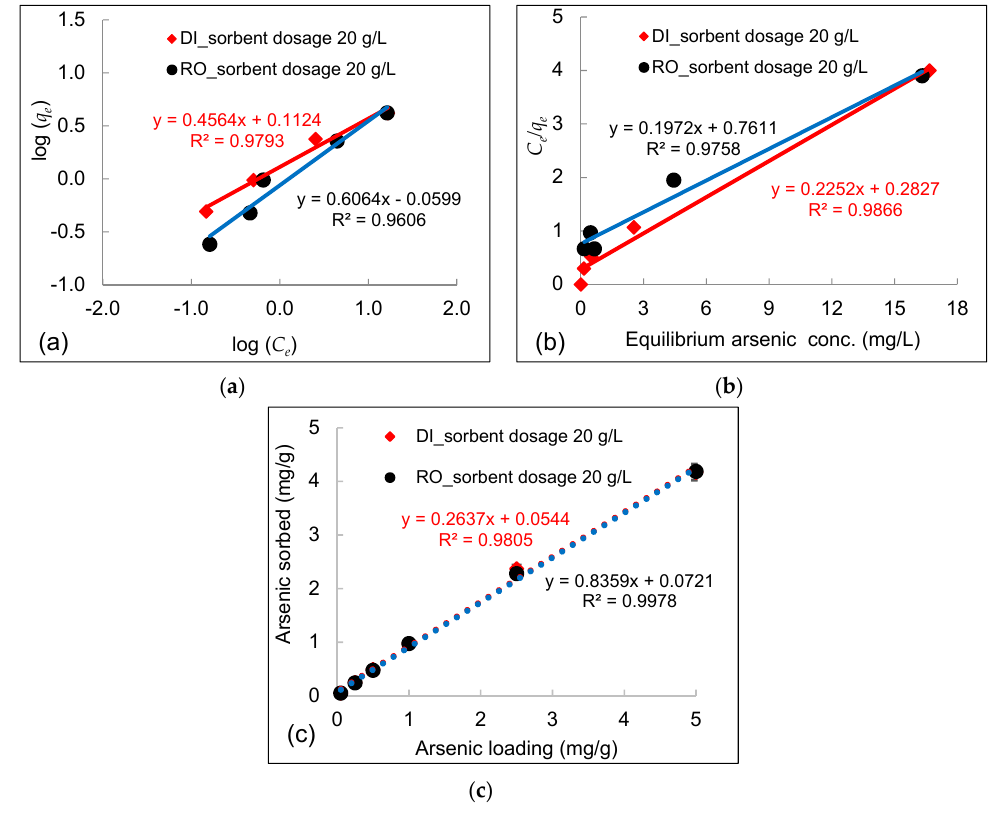
Figure 5. Effect of initial arsenic concentration in RO concentrate and deionized water at high sorbent dosage (20 g/L) with pH 7 and 23 °C. ( a ) Freundlich isotherm; ( b ) Langmuir isotherm; ( c ) Amount of arsenic sorbed. The error bars represent the standard deviation of duplicate or triplicate testing results.